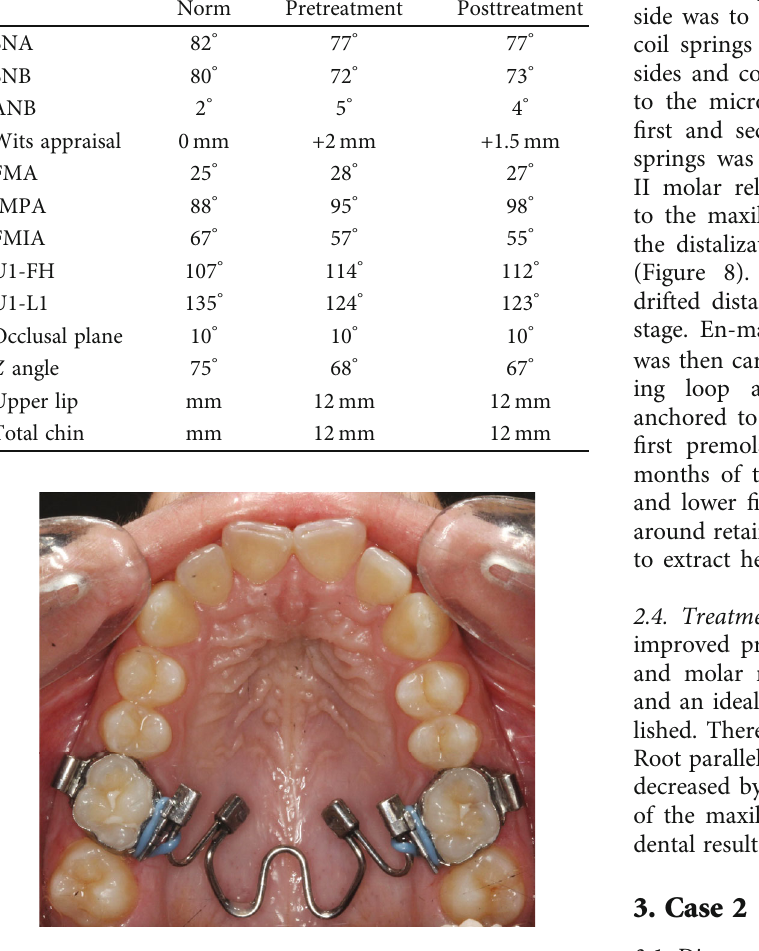
Figure 7: Case 1. Derotation of maxillary fi rst molars with a nickel- titanium molar rotator.